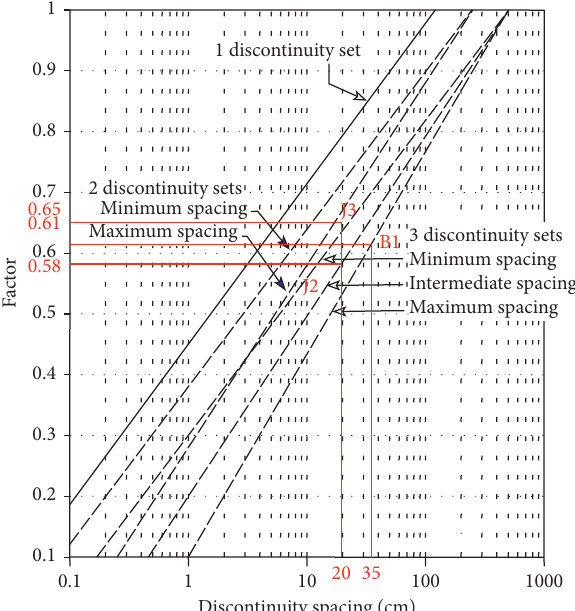
Figure 6: Factor determination graph in accordance with the discontinuity spacing [16]. Table 5. A final assessment of the slopes (see Table 5) was Table 3: Weathering degree and its classification.